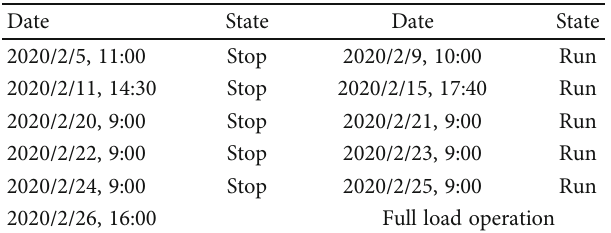
Figure 2: (a) The main drilling working face; (b) auxiliary drilling working face; (c) pro fi le of freezing pipes. Table 1: Intermittent freezing